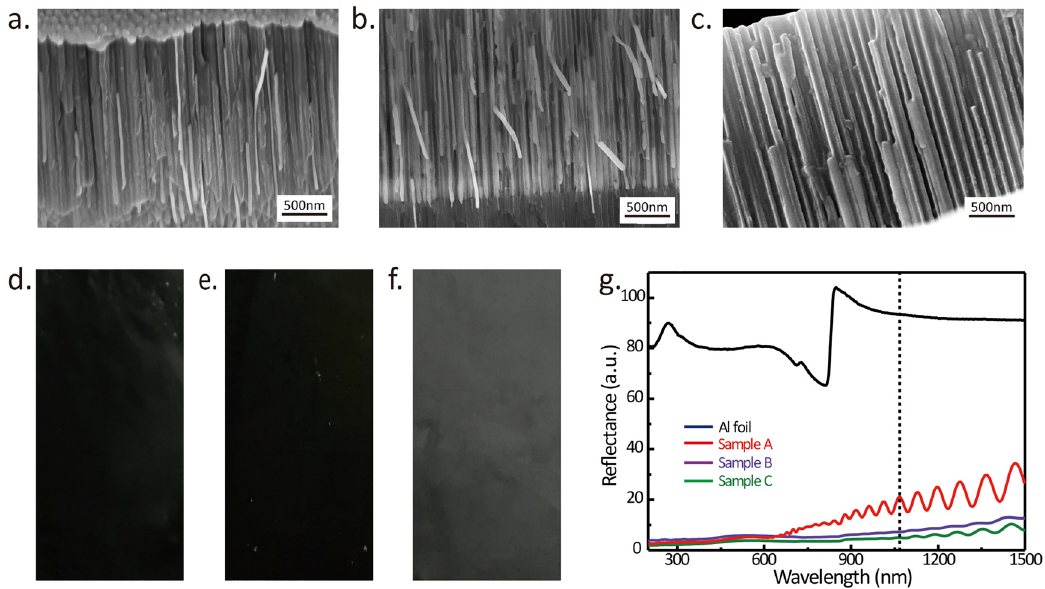
Figure 2: (a – c) The cross-sectionSEM images of APA-AAO samplesA, B, andC, respectively, wherethe holediametersare 50, 70, and100 nm respectively; (d – f) The microscopic appearance images of APA-AAO Sample A, B, and C; (g) The measured re fl ection spectra of the Al foil (black), the APA-AAO Sample A (red), B (green), and C